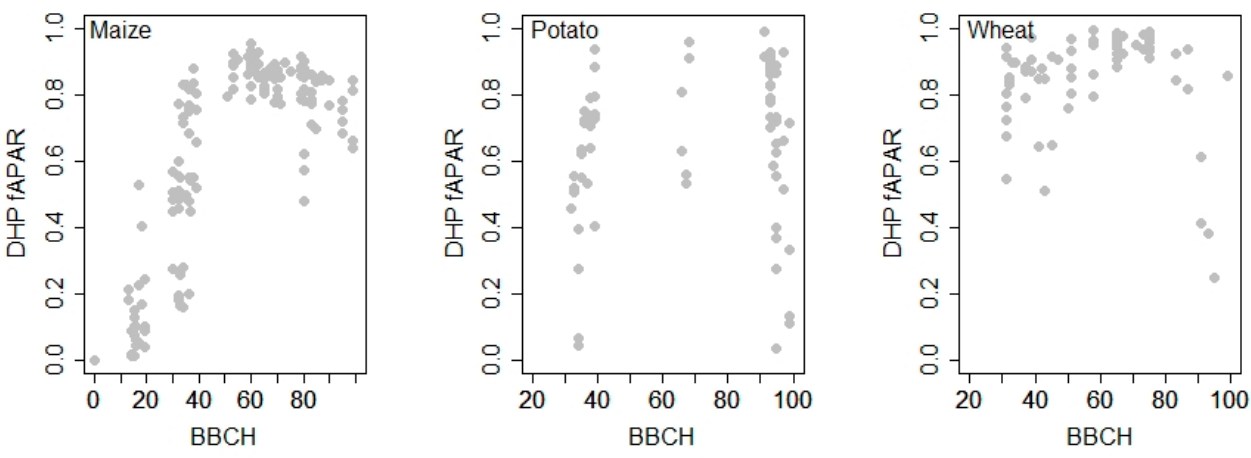
Figure 15. BBCH codes and DHP-derived fAPAR for maize, potato, and wheat for the period 2015–2017. See Figure 14 for BBCH codes.